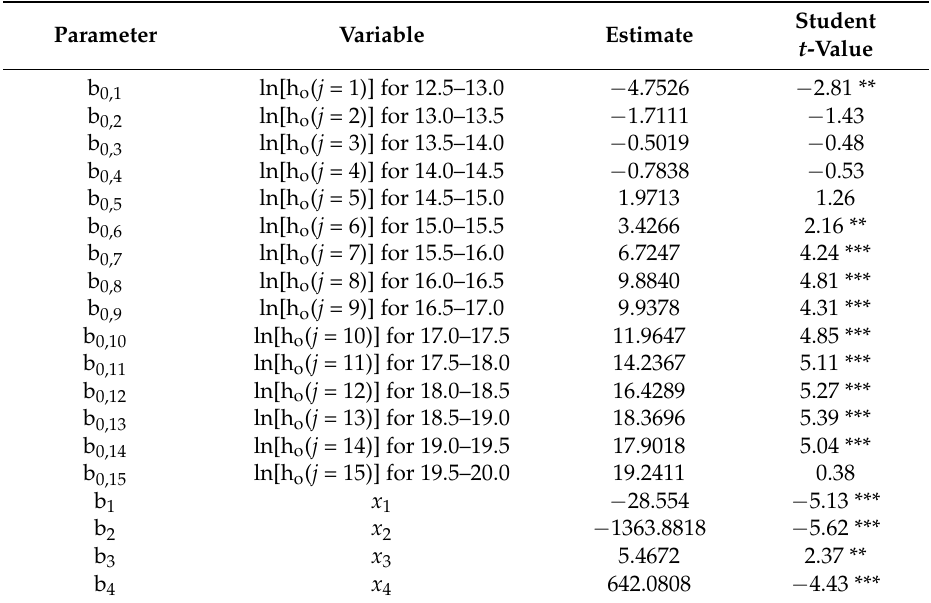
Table 3. Estimation of the parameters in Equation